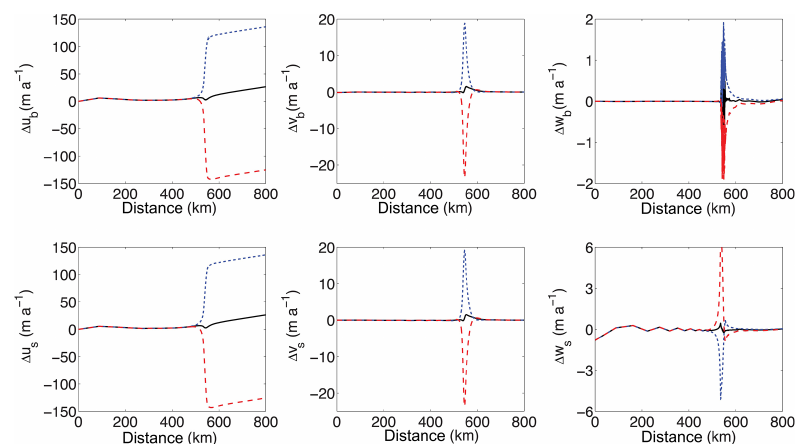
Figure 3. Comparisons of across-flow-averaged velocity differences for lower ( (cid:49)u b , (cid:49)v b , and (cid:49)w b ) and upper ( (cid:49)u s , (cid:49)v s , and (cid:49)w s ) surfaces along the x direction for FELIX-S and Elmer/Ice for the diagnostic experiment P75D. The blue dotted, black solid, and red dashed lines denote the differences by subtracting Elmer/Ice LG, DI, and FF values from FELIX-S values,